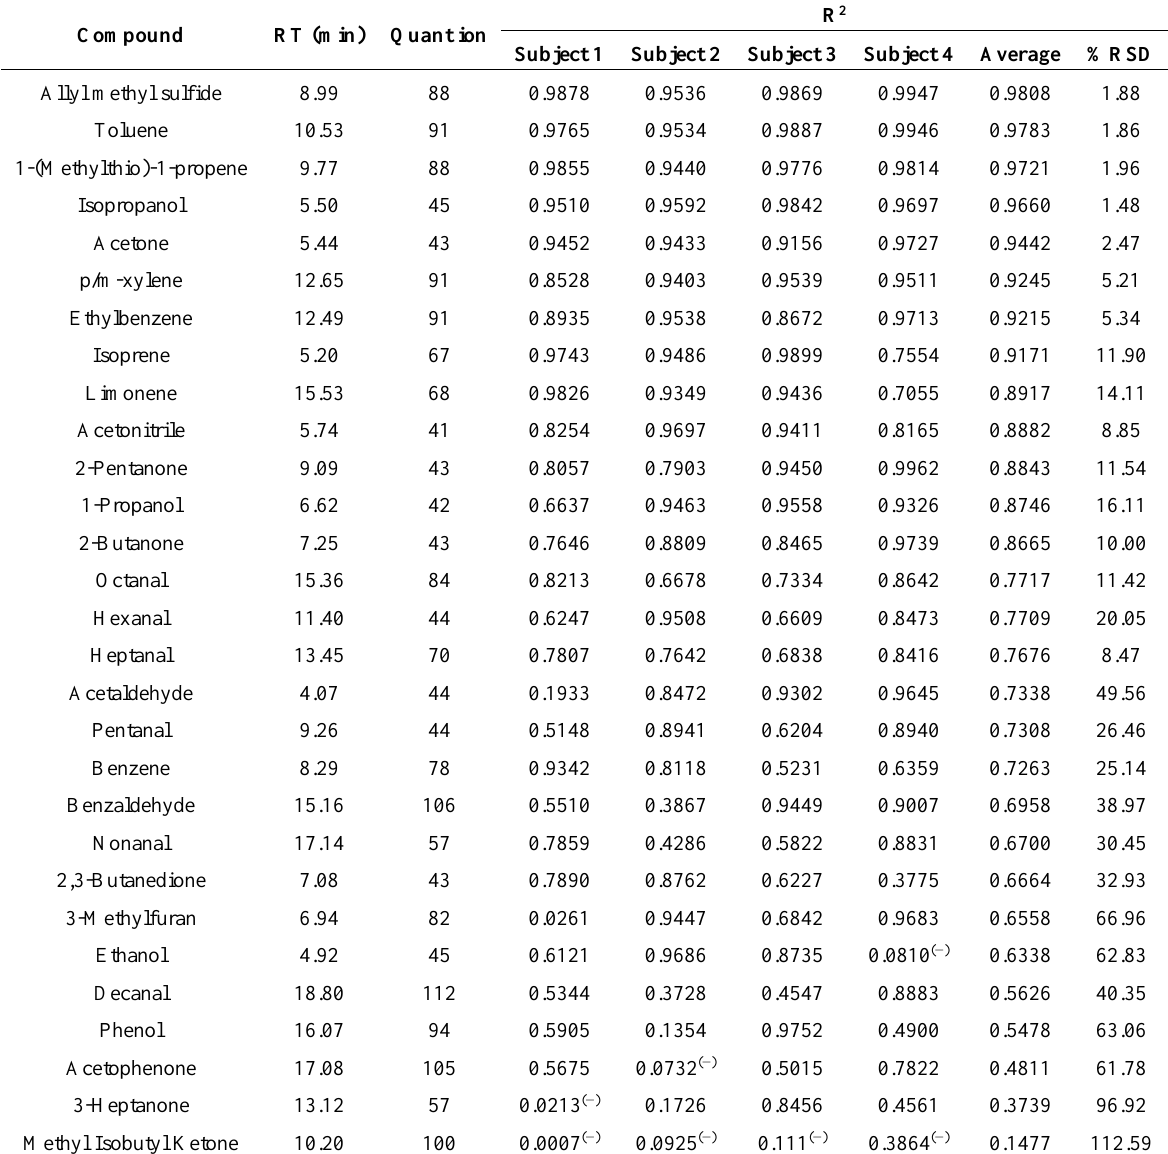
Table 2. Retention time, quantitative ion and regression coefficient (R 2 ) for the breath volatile organic compounds identified from repeated collections using the Bio-VOC sampler. R 2 values are provided to demonstrate linearity of compounds over multiple collections. The list of the compounds was sorted in decreasing order of the mean R 2